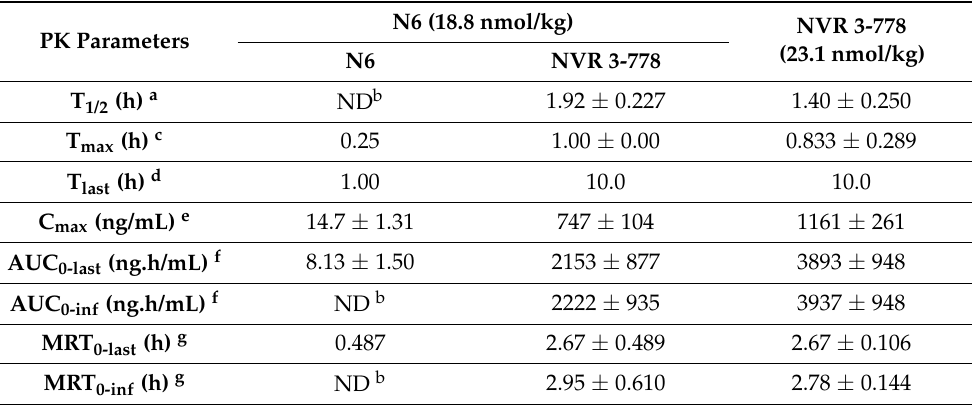
Figure 2. Plasma drug concentration–time curve of N6 and NVR 3-778 after oral administration. Table 4. Main pharmacokinetic parameters after oral administration of N6 and NVR 3-778.